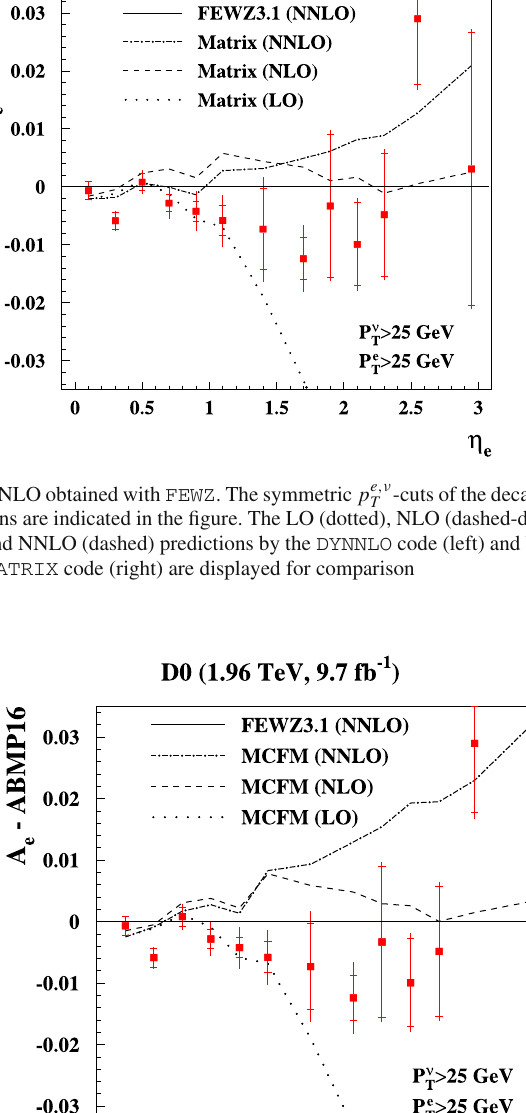
difference exceeds the size of the pure NNLO